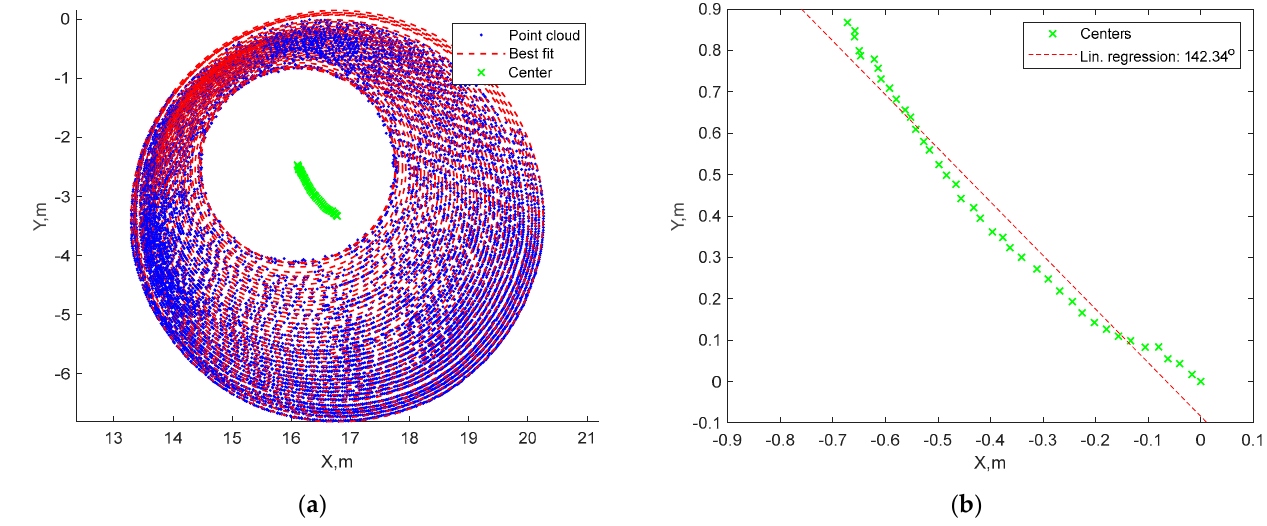
Figure 20. Analysis of residual inclination from point cloud—plan views: ( a ) cross-sections of the minaret with best fit circles and their centers; ( b ) centers of circles in the horizontal plane.